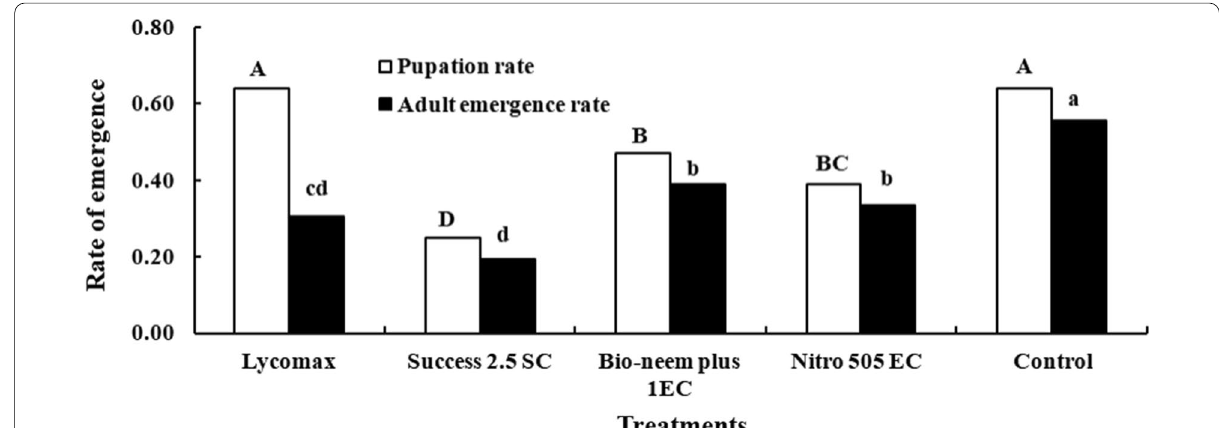
Fig. 2 Efficacy of different treatments on pupa and adult emergence of P. 14-punctata under laboratory condition (all means followed by same letters at each bar are not significantly different by Tukey’s multiple range tests, ANOVA ( P <